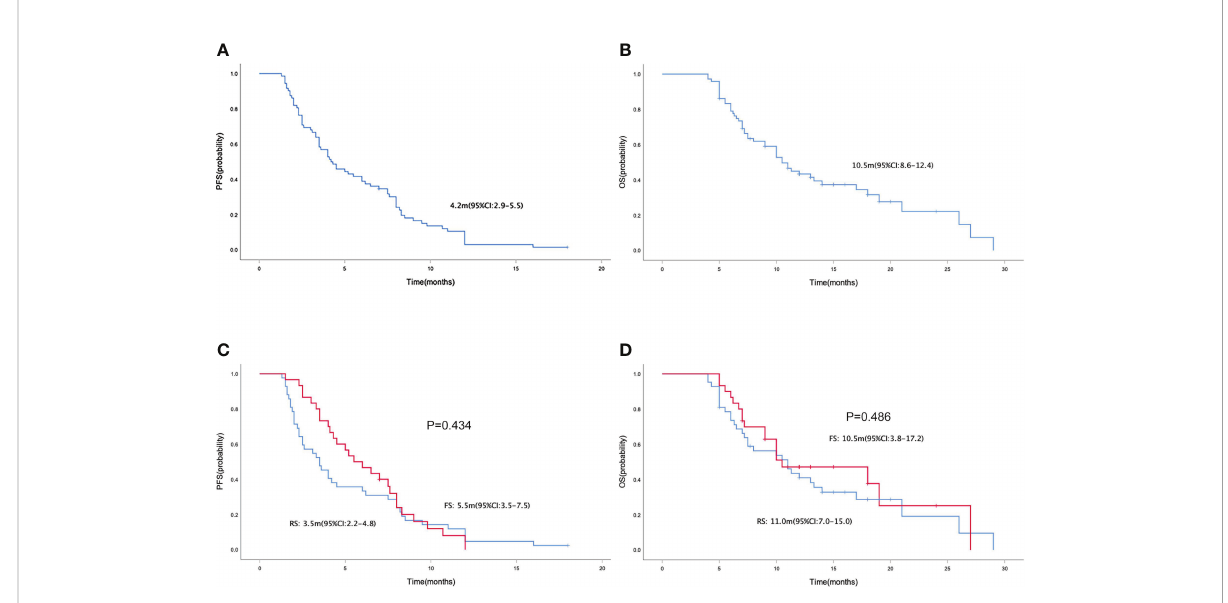
FIGURE 1 Kaplan-Meier curve of PFS (A) and OS (B) in the general population. Kaplan-Meier curve of PFS (C) and OS (D) in the regorafenib plus sintilimab (RS), and fruquintinib plus sintilimab(FS)